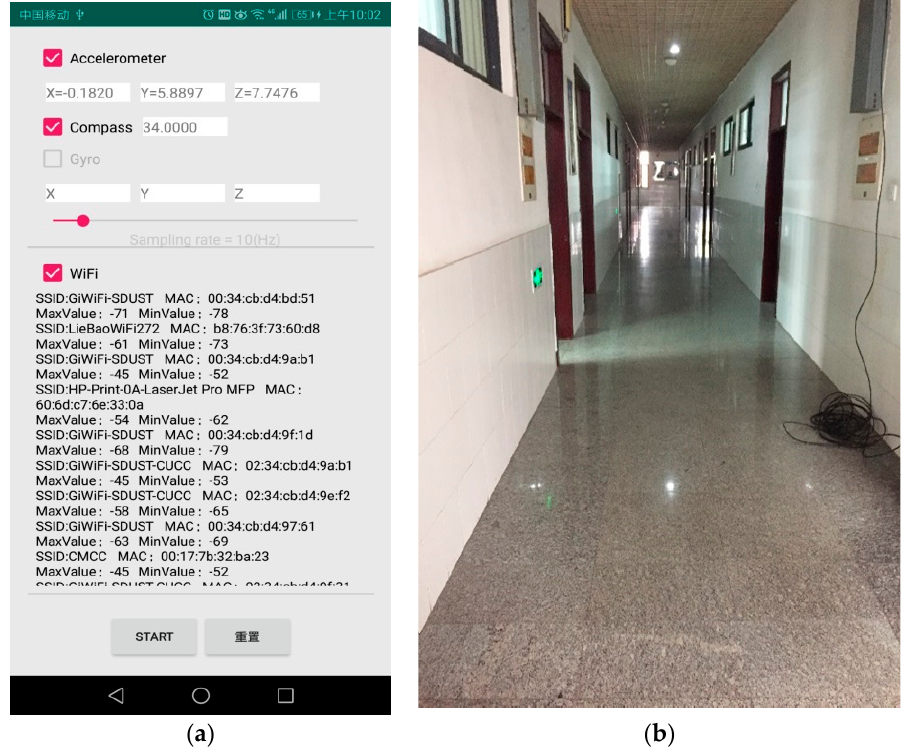
Figure 3. Collection of the RSSI values and MAC addresses of APs: ( a ) The interface of signal acquisition software; ( b ) The actual environment of data collection.